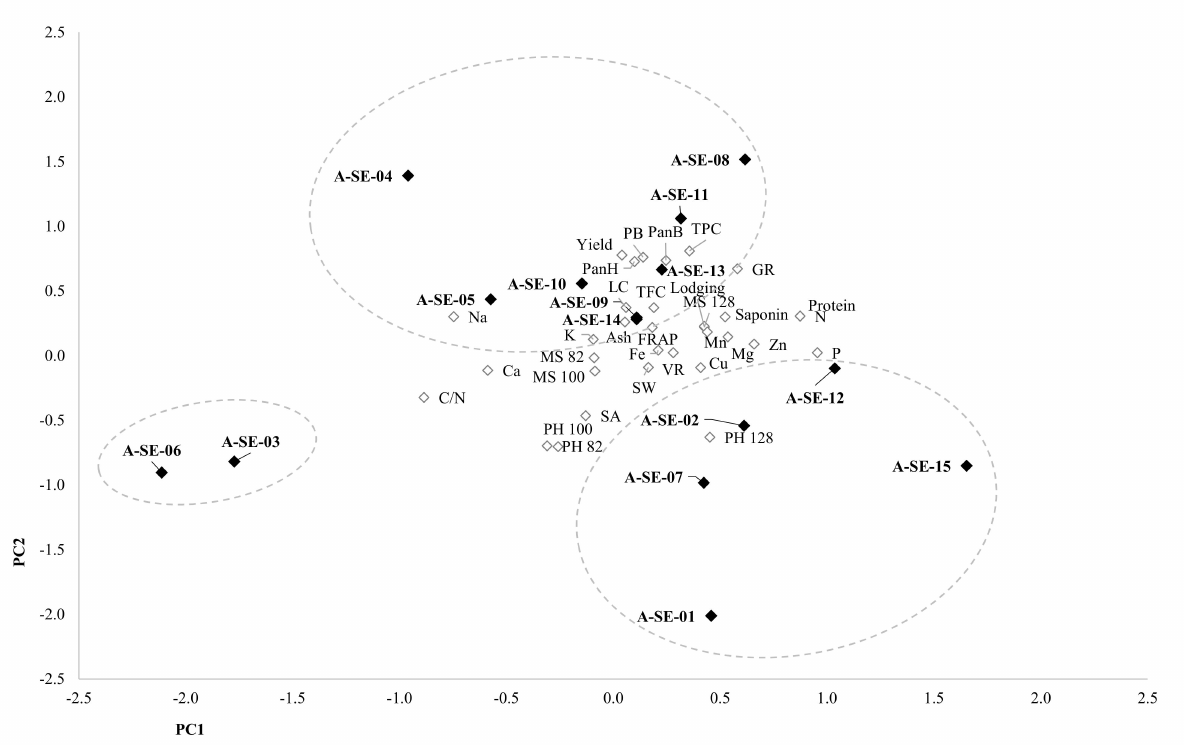
Figure 9. Principal components analysis (PCA). Biplot of main components 1 and 2 for the cultivars sown and for the variables tested. Component 1 (X-axis) was contributed mainly by protein and saponin contents, germination rate, minerals (P, Mg, Ca (-), Na (-), Mn, Cu, Zn), lodging, plant height at 128 d.a.s., and mildew at 128 d.a.s. Component 2 (Y-axis) included germination rate, total phenolics content, plant height (-), plant biomass, panicle height, and panicle weight